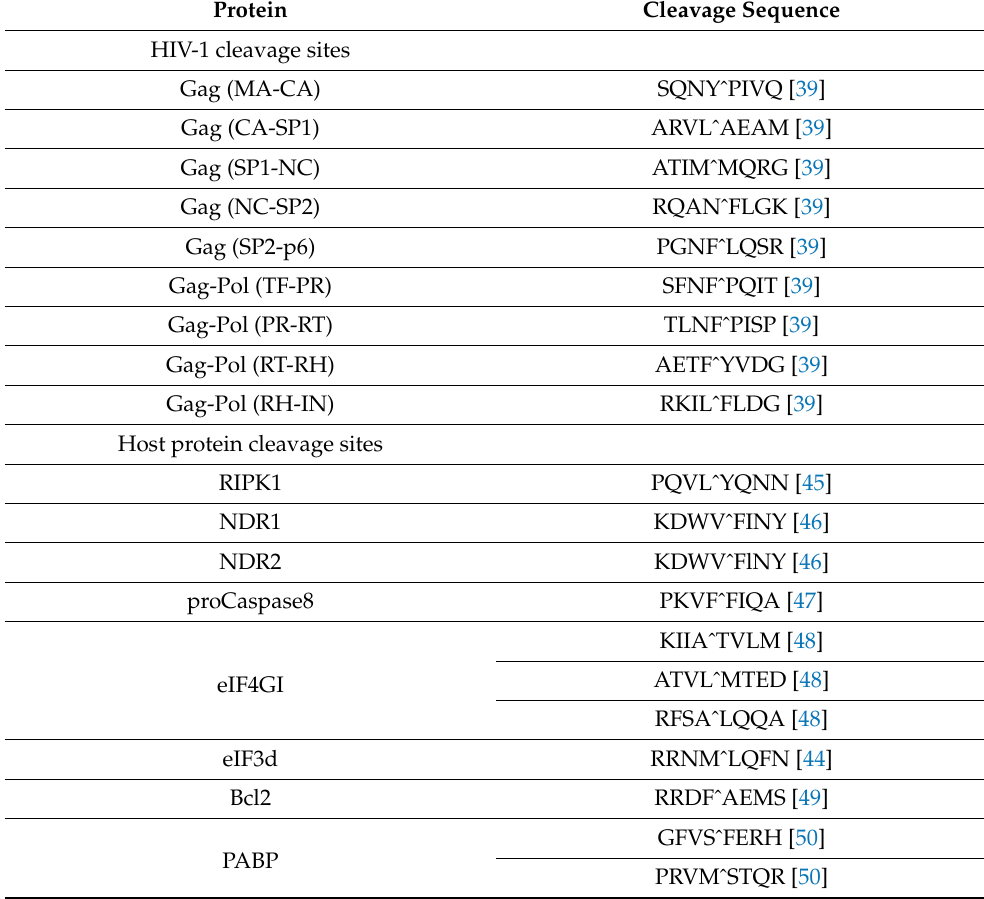
Table 1. HIV-1 PR cleavage sites validated in cell culture systems. Gag and Gag-Pol domains are expressed as abbreviations as follows: matrix protein, MA; capsid protein, CA; spacer peptide 1, SP1; nucleocapsid protein, NC; spacer peptide 2, SP2; transframe region, TF; protease, PR;